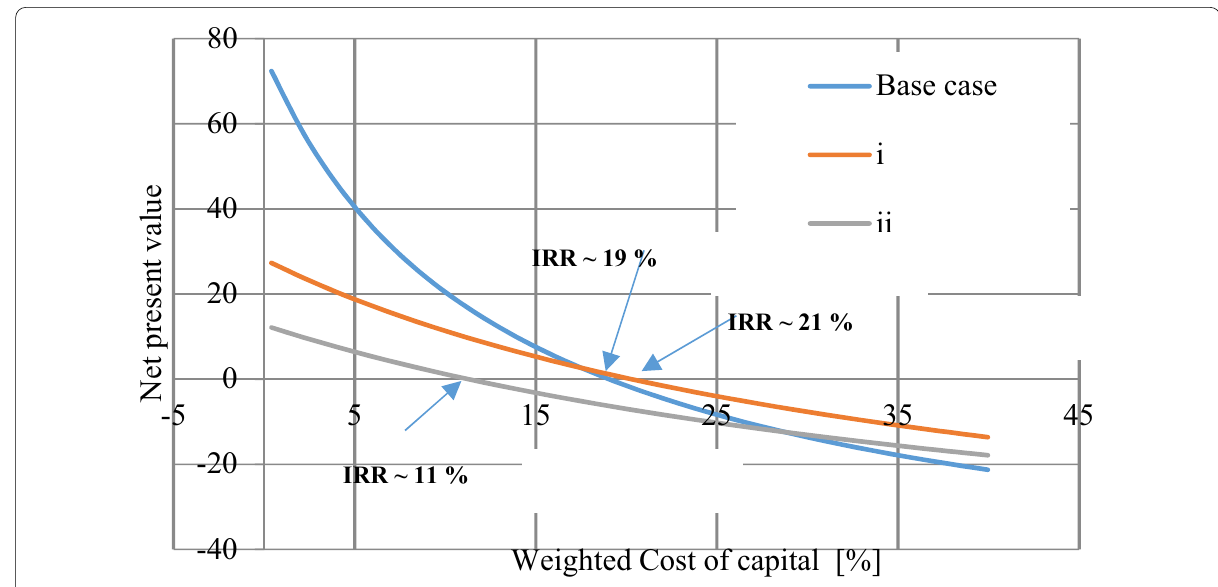
Fig. 8 Illustration of net present values (million) for three different debt-to-equity ratios